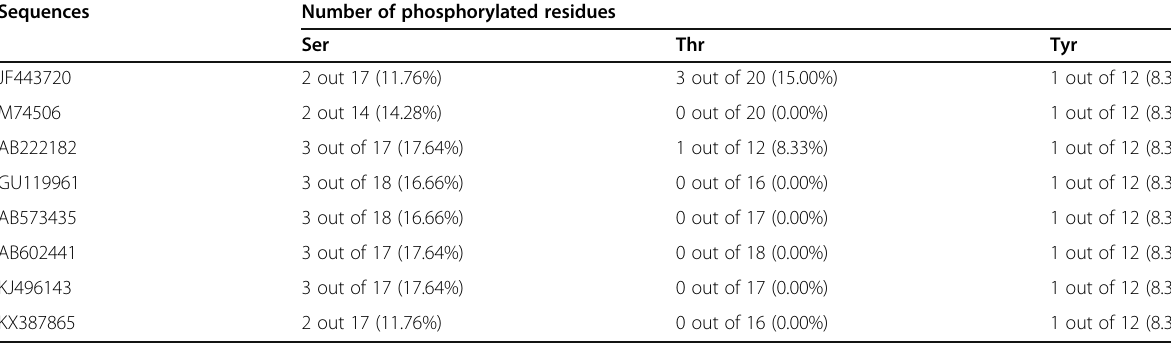
Table 3 Predicted number and percentage of phosphorylated residues in YDR of hepatitis E viruses